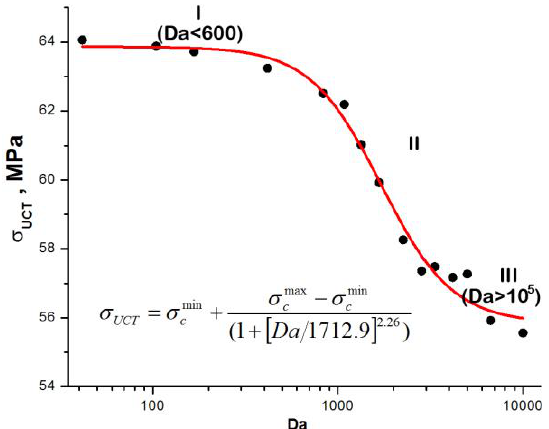
Fig. 1. Numerically derived dependence of compressive strength  UCT of model samples of concrete with only capillary pores on the analogue of the Darcy number Da . Points are numerically obtained strength values. The solid curve is the approximating logistic curve with the following parameters:  с min =55,8 МPa (the minimum strength value of a concrete sample, achieved under condition of negligible rate of filteration),  с ma х =64 MPa (the maximum value of strength, which corresponds to the strength of a dry sample or quasistatically deformed water-saturated